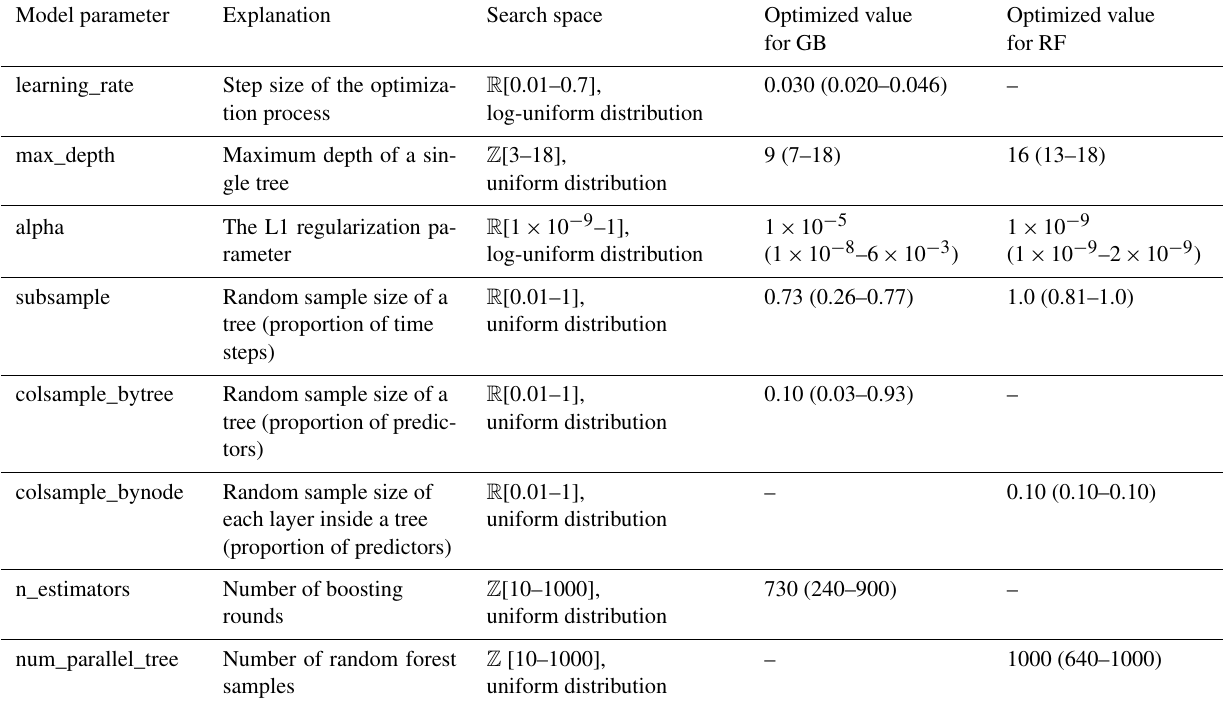
Table 2. Optimized hyperparameters of the GB and RF regression models. The root mean squared error was used as the cost function in the Bayesian optimization. Constant default values of other model parameters were used, and they are not presented here. Identified median values of parameters, and minima and maxima inside brackets, are